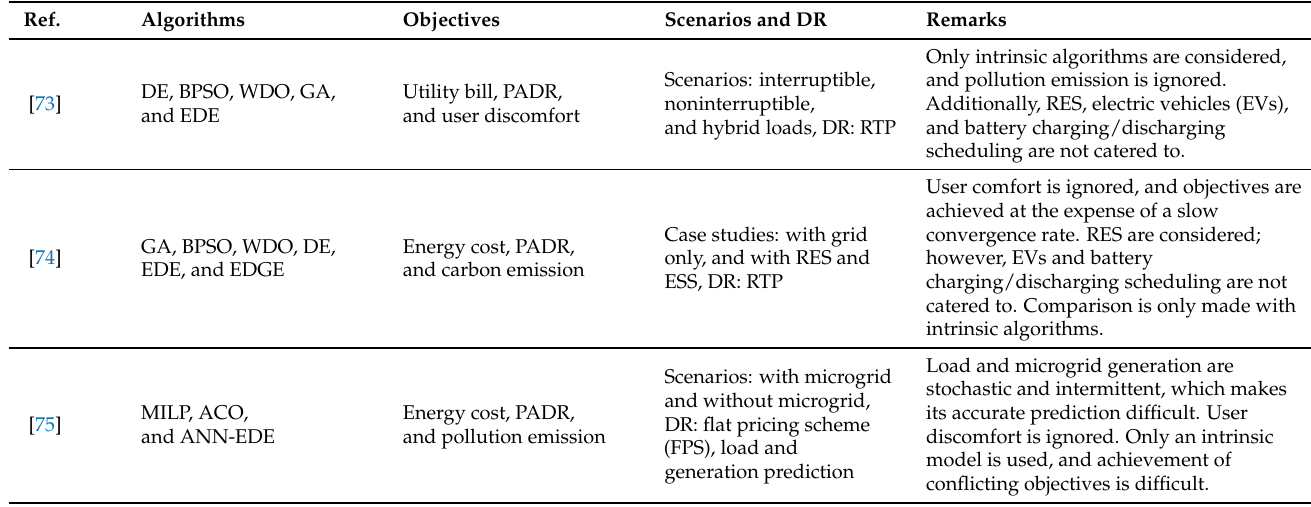
Table 1. Summarized related